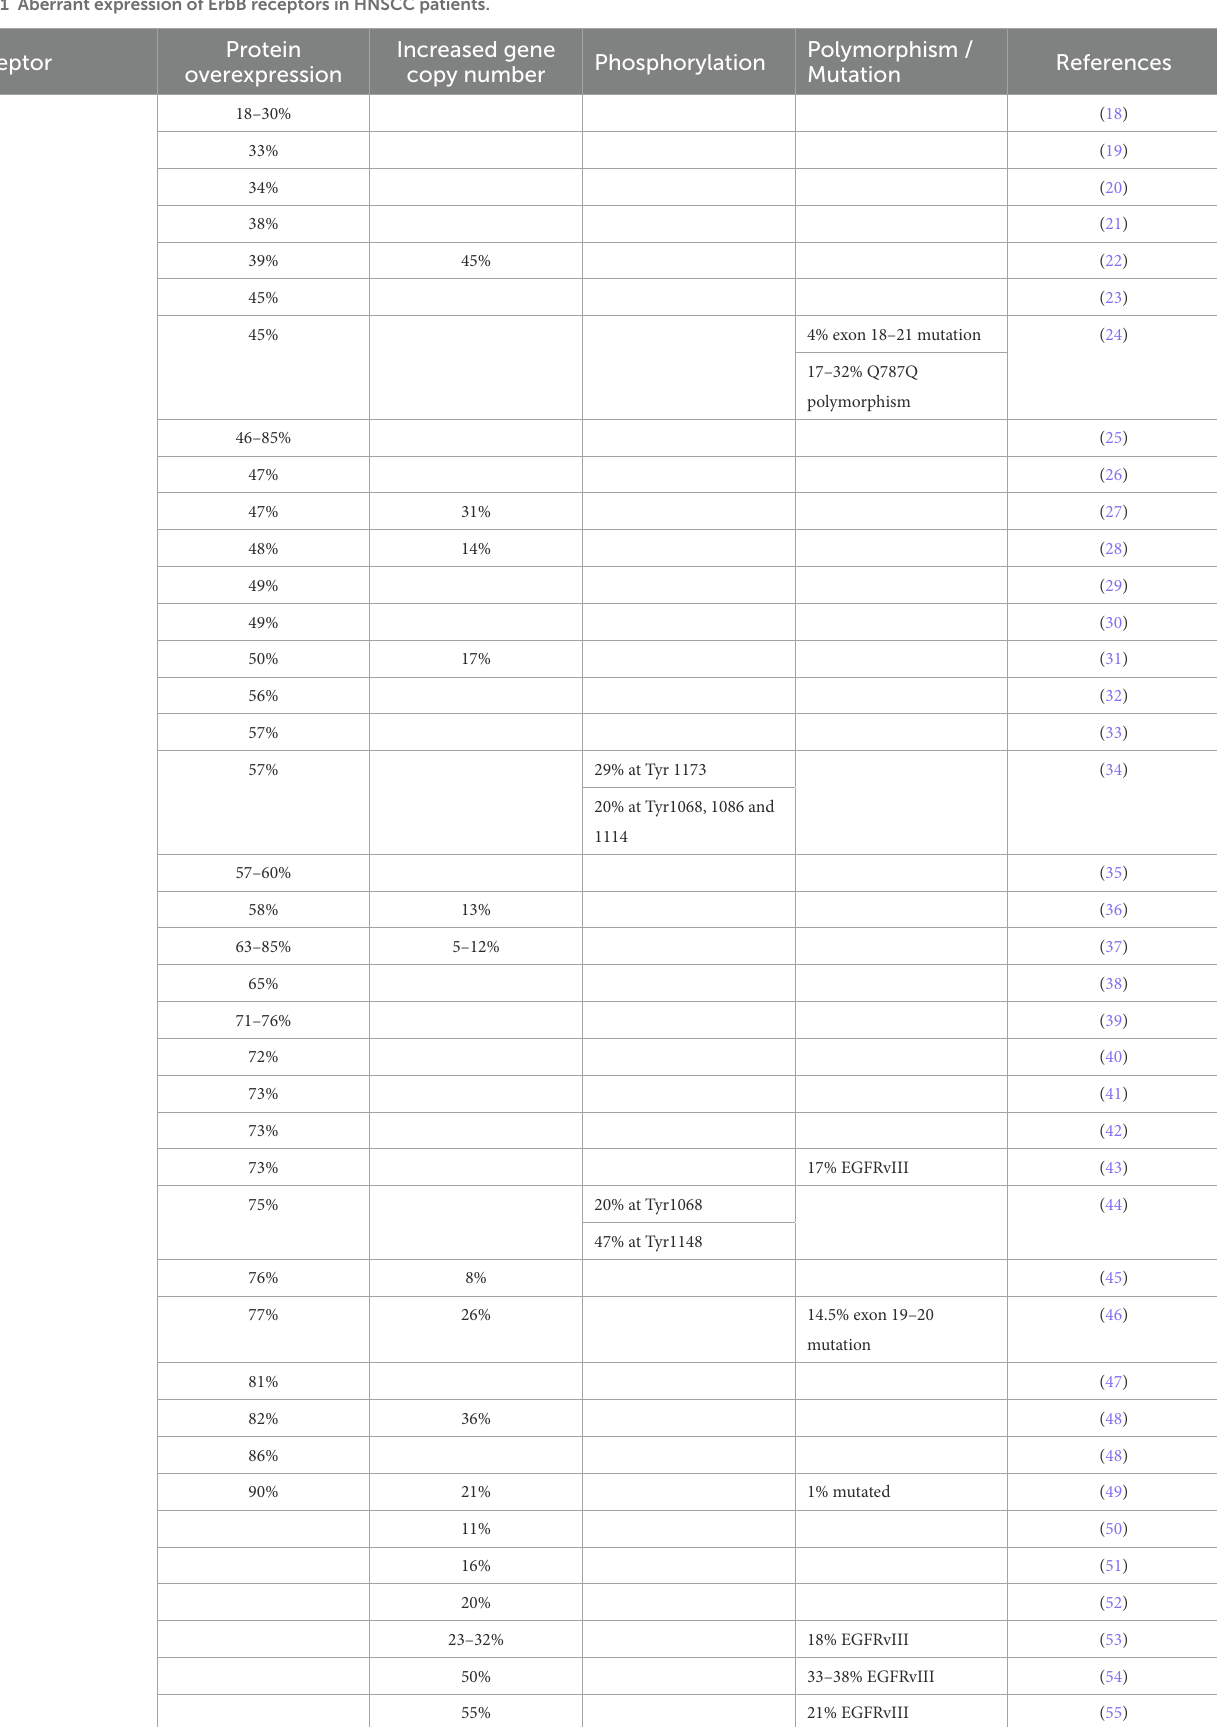
TABLE 1 Aberrant expression of ErbB receptors in HNSCC patients. Receptor